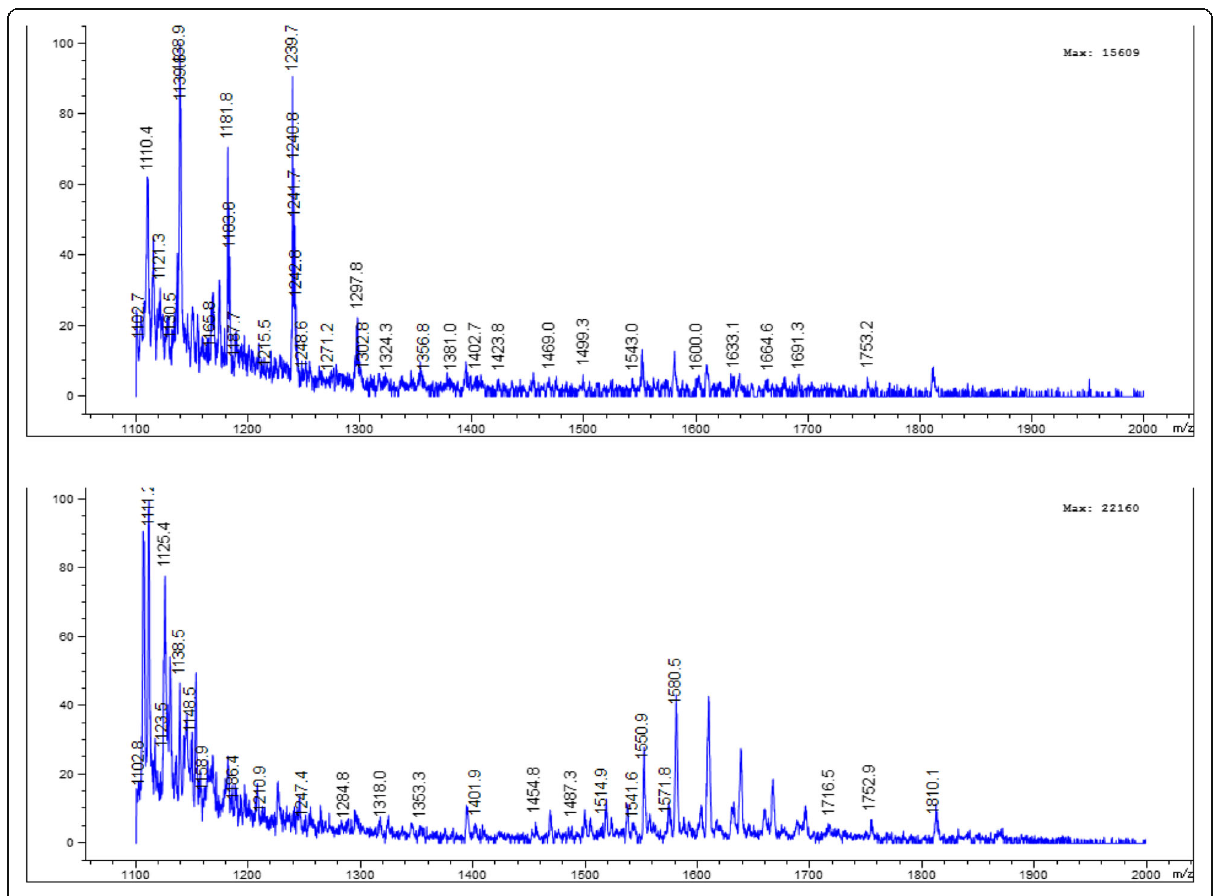
Fig. 4 An example of the mass spectrum profile of the DOTA-Ahx-BN prepared from cyclen procedure (above) and with DOTA-tris (t-Bu ester) (below). It can be seen that no overalkylating product was observed when the DOTA-Ahx-BN synthesized by the cyclen approach. While tetraalkylating product 1813 (M + t-Bu + H) + is clearly visible in the spectrum when the DOTA-peptide was prepared using DOTA-tris (t-Bu ester)